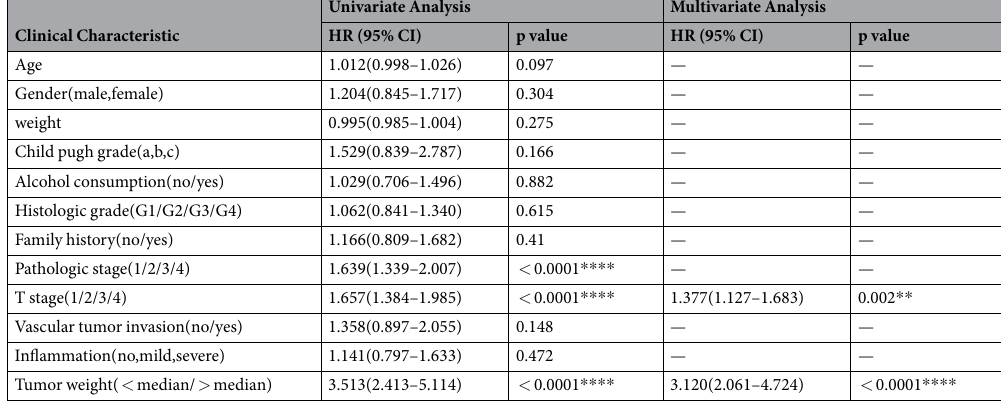
Table 1. The relationship between clinical characteristics and survival time of HCC patients. Variables with p < 0.1 in univariate analysis were included in the multivariate analysis using a forward conditional method. Abbreviations: CI, confidence interval; HR, hazard ratio. Statistical significance is marked with the star symbol: ** p < 0.01, **** p <